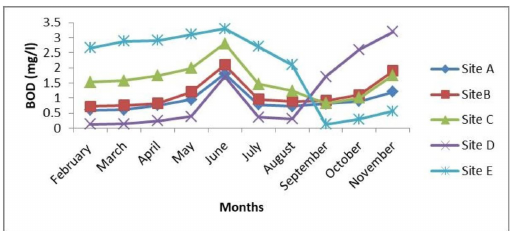
Figure 8. Monthly mean variations in phosphate-phosphorus of Nasarawa Reservoir.